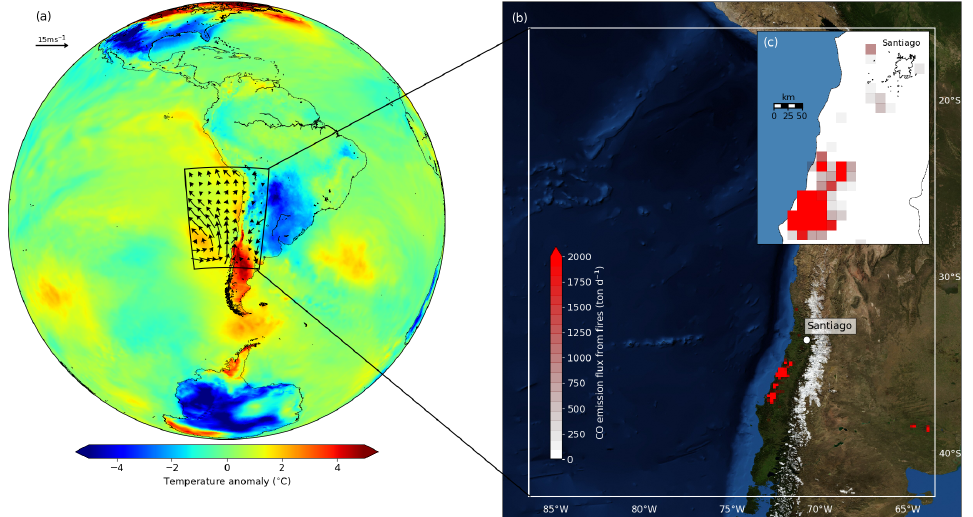
Figure 1. ( a ) Temperature anomaly between 25 and 29 January w.r.t. January 2017 average, and associated mean wind field. Data from ERA5 hourly surface reanalyses [45]. ( b ) Simulation domain (white boundaries) and CO emissions from the main fire areas on 29 January. Emission data from CAMS GFAS [40] pre-processed for CHIMERE. Map background layer: Imagery World 2D, ©2009 ESRI. ( c ) Zoom on the region of